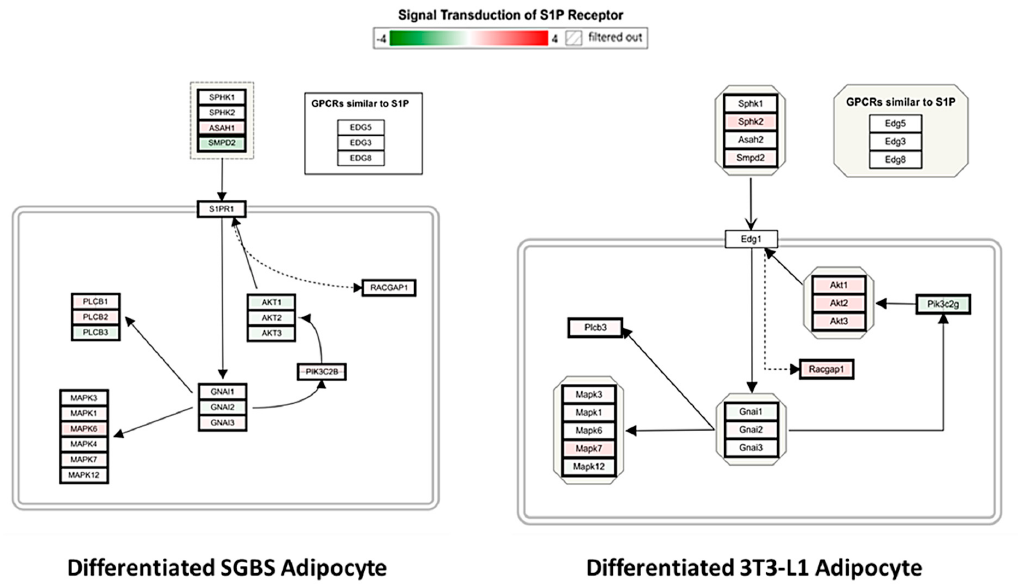
Figure 8. Mapping the S1P-S1PR 1 signaling pathway in differentiated SGBS and 3T3-L1 adipocytes. WikiPathway was used to identify and visualize genes involved in the S1P-S1PR 1 signaling axis in S1P-treated differentiated SGBS and 3T3-L1 adipocytes compared to the vehicle control. S1PR 1 refers to sphingosine-1-phosphate receptor 1.